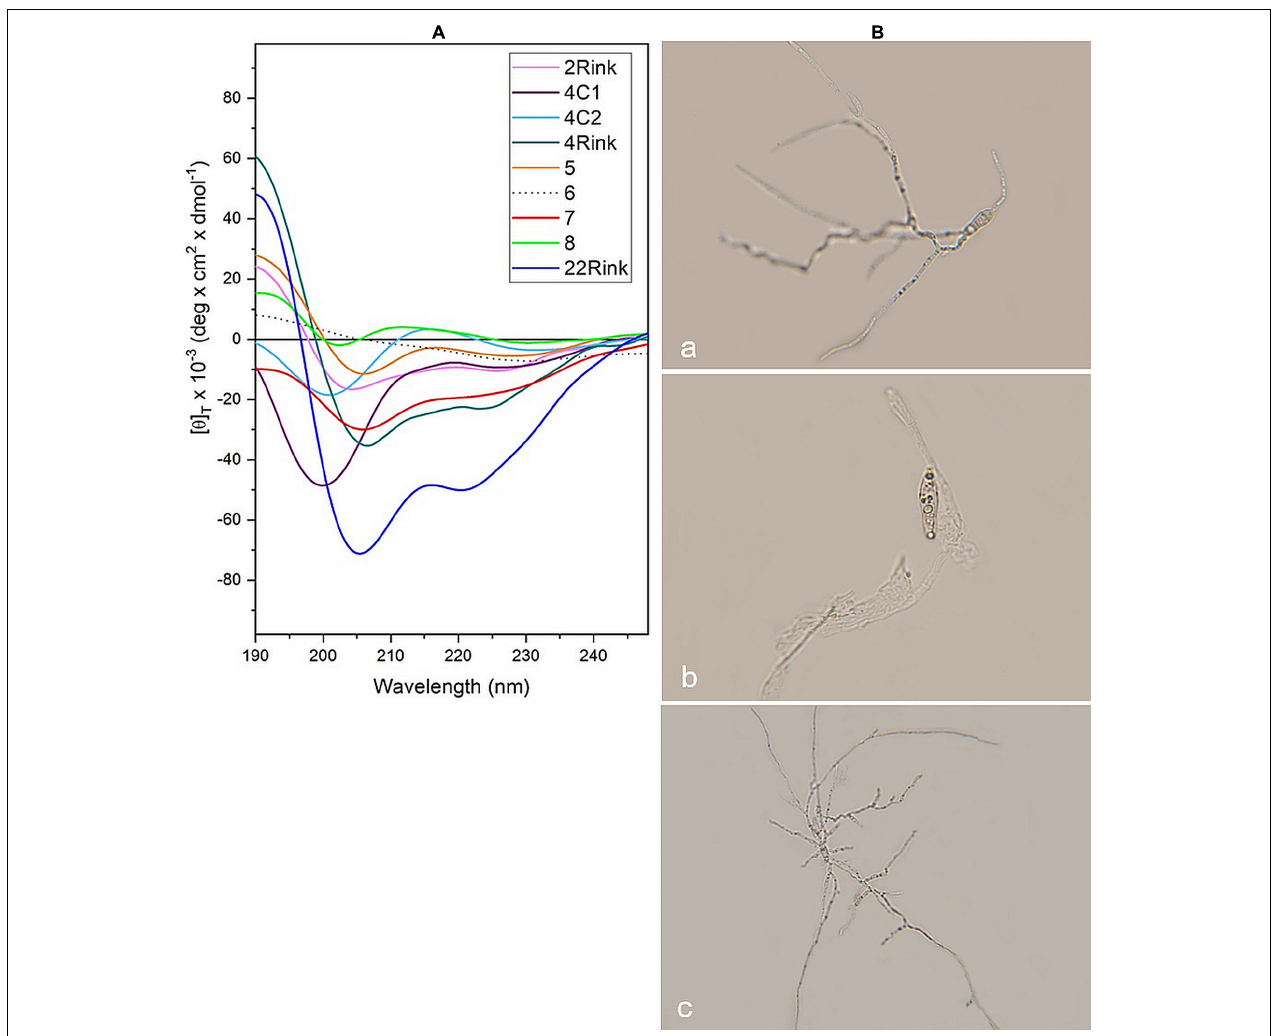
FIGURE 5 | (A) CD spectra acquired in vitro for pep 2Rink, 4Rink, 4C1, 4C2, 5, 6, 7, 8Api and 22Rink at 50 µ M in the presence of Pyricularia oryzae (IT10 strain) incubated for 48 h in phosphate buffer pH 7 at 25 ◦ C; (B) Optical microscopy pictures representing P. oryzae conidia untreated (a) and after 48 h of incubation with Pep 2Rink (b) or Pep 6 (c) in 10 mM phosphate buffer at pH 7. In the presence of the non-effective Pep 6, the fungal mycelium grew better than the untreated